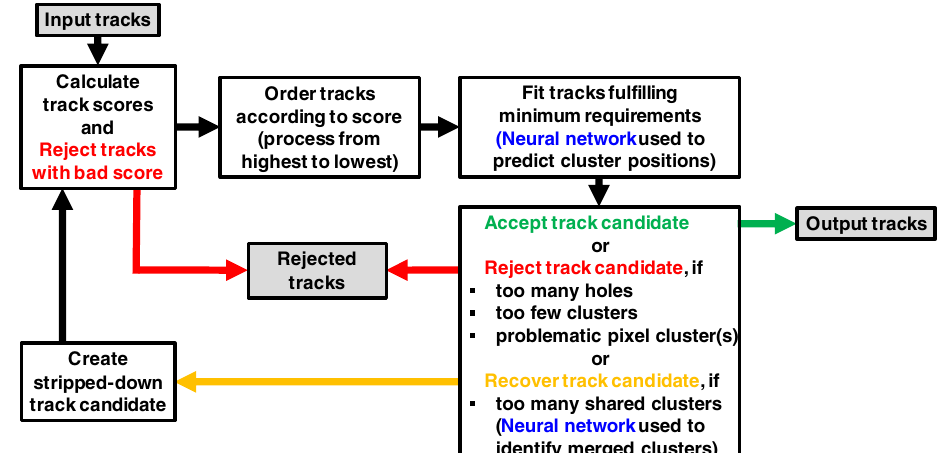
Fig. 3 Sketch of the flow of tracks through the ambiguity solver